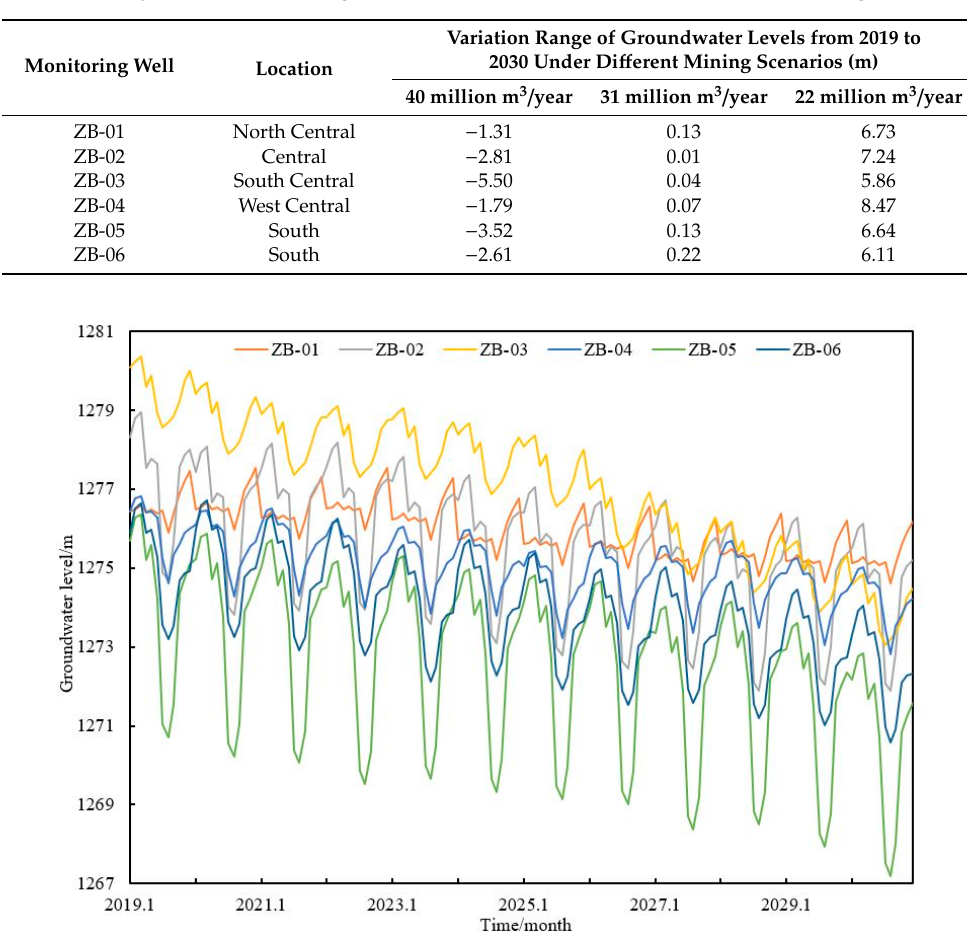
Figure 9. Duration curves of groundwater levels in six monitoring wells from 2019 to 2030 under the existing mining scenario.